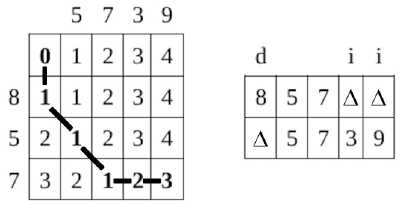
Figure 3. Distance matrix and alignment in Example